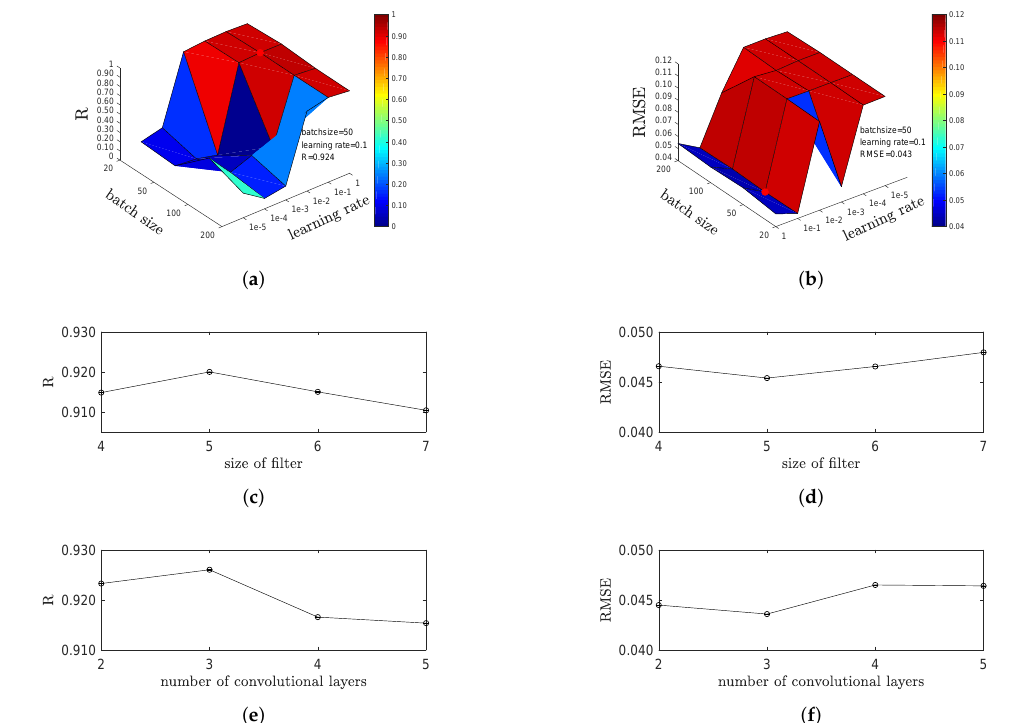
Figure 4. Effects of four hyperparameters on the retrieval performance on the same training data set. ( a ) R values achieved by applying different batch sizes and learning rates; ( b ) RMSE values achieved by applying different batch sizes and learning rates; ( c ) R values achieved by applying different sizes of filters; ( d ) RMSE values achieved by applying different sizes of filters; ( e ) R values achieved by applying different numbers of convolutional layers; ( f ) RMSE values achieved by applying different numbers of convolutional